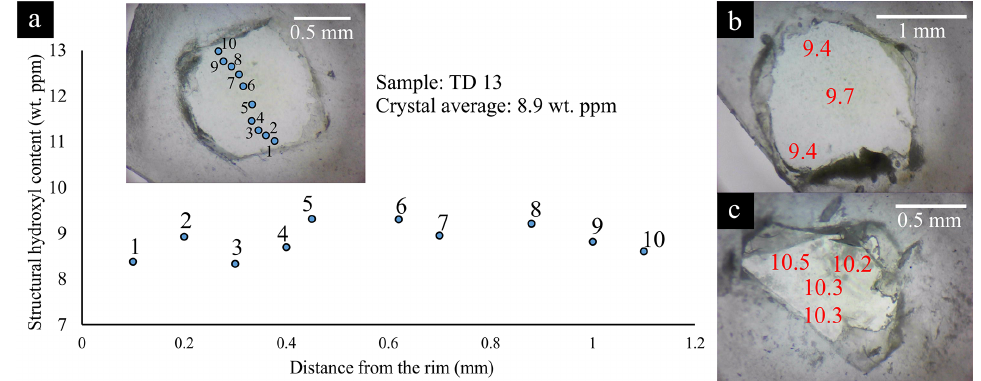
Figure 7. Example of structural hydroxyl concentration along a transect (a) and observed in core–rim relation (b, c) . Note that no significant difference in structural hydroxyl content was observed along a transect nor in core vs. rim